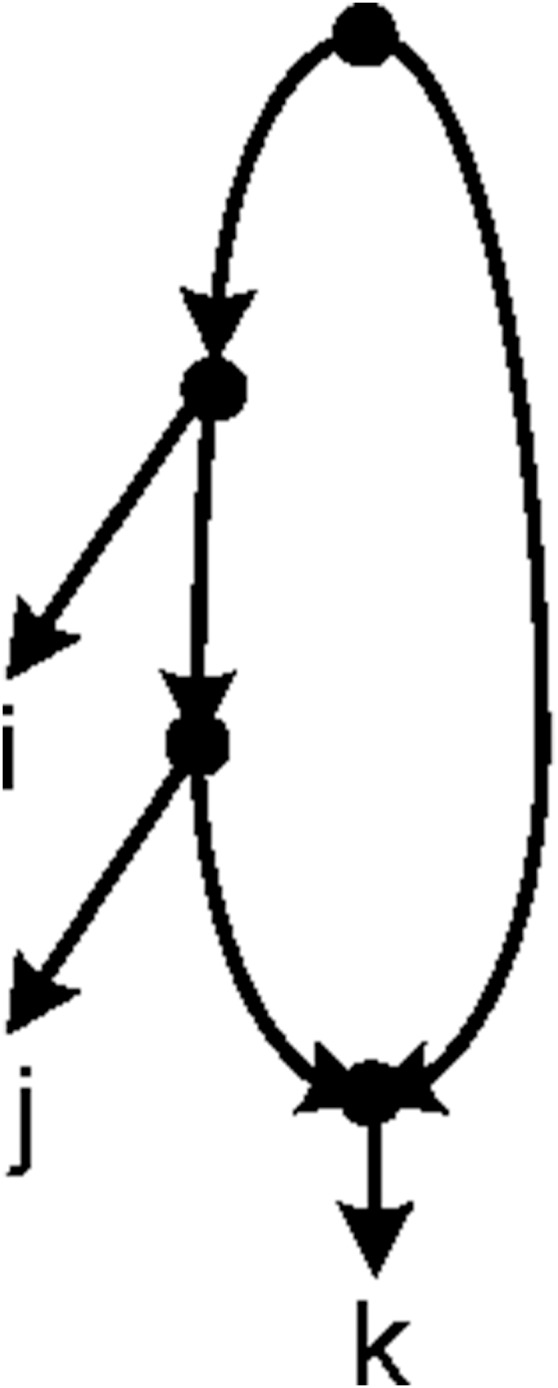
A counter example for the reverse of Theorem 2.
ij|k is consistent with the given network, but h(i,j) = h(i,k) = 3 and h(j,k) = 2.